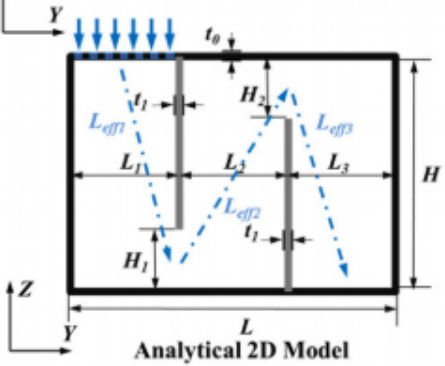
Figure 17. An approximate analytical two-dimensional (2D) model of a unit cell of a space-coiled metamaterial [57].